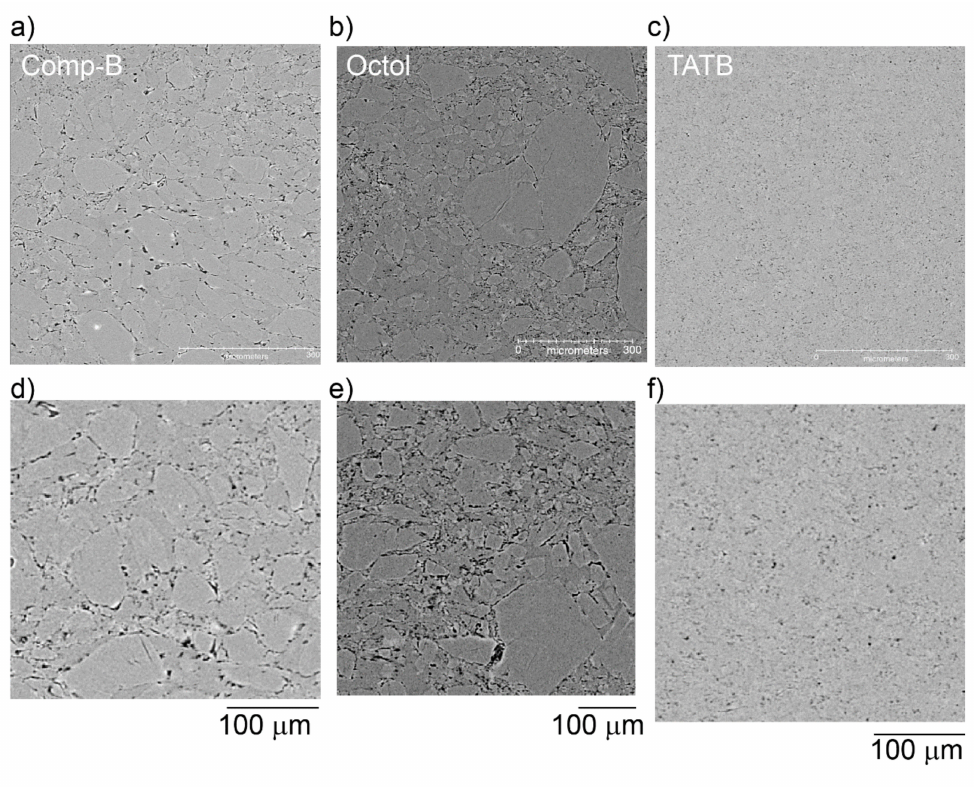
Figure 8. Typical µ CT reconstructed slices of the microstructure for Composition B ( a , d ), Octol ( b , e ), and TATB ( c , f ) at two fields of